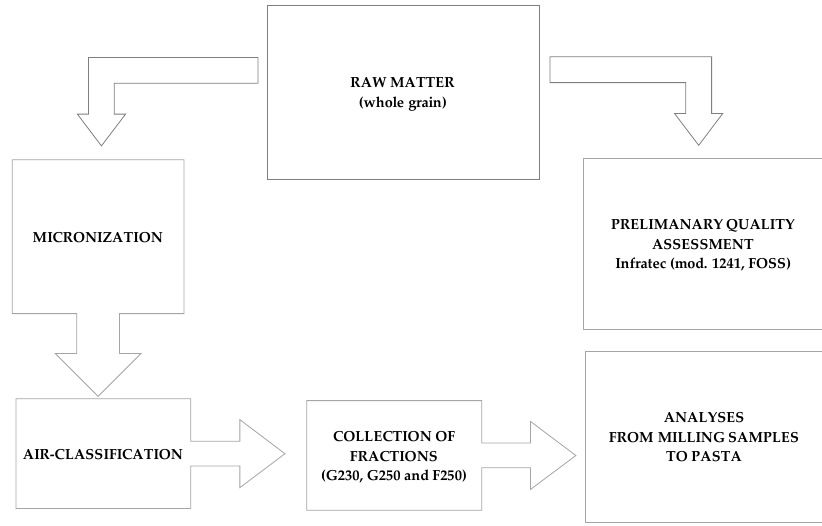
Figure 1. Flow chart of the experimental plan.